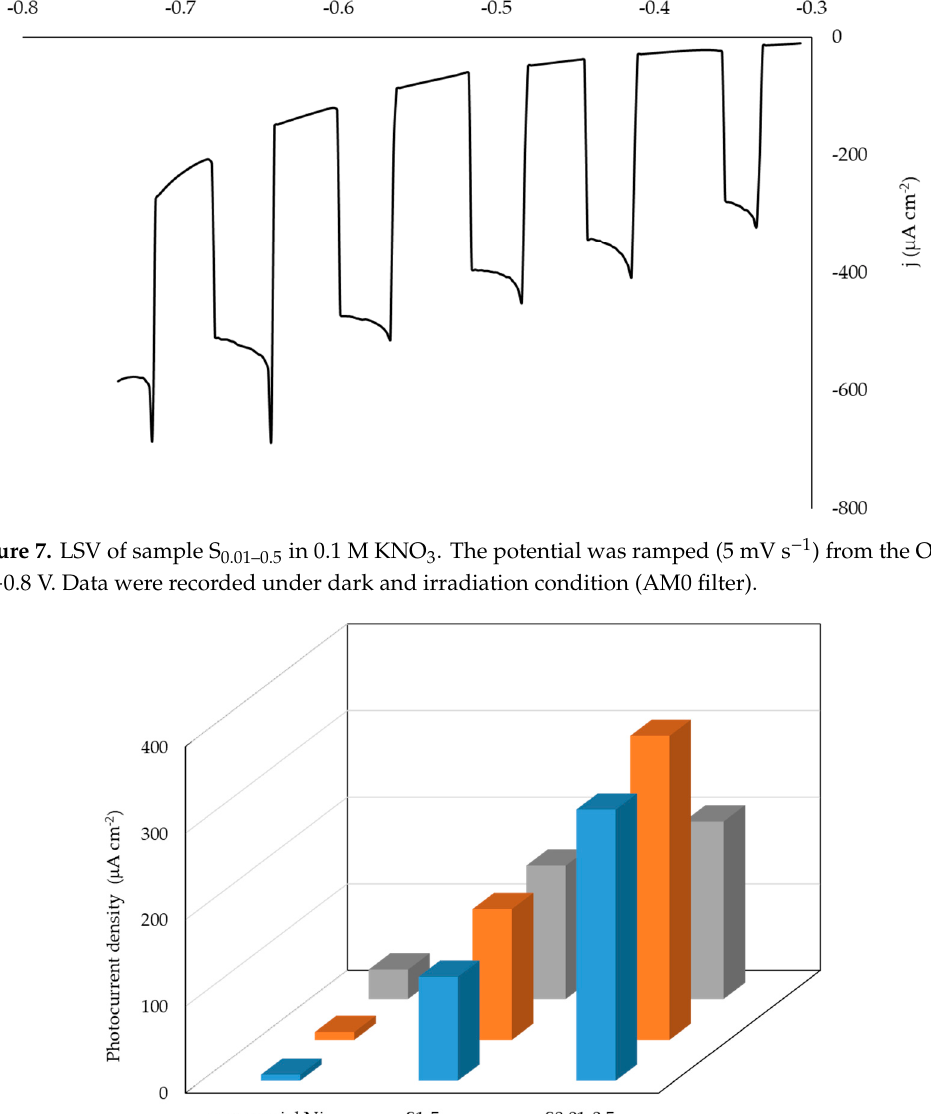
Figure 7. LSV of sample S 0.01 – 0.5 in 0.1 M KNO 3 . The potential was ramped (5 mV s − 1 ) from the OCP to − 0.8 V. Data were recorded under dark and irradiation condition (AM0 filter).